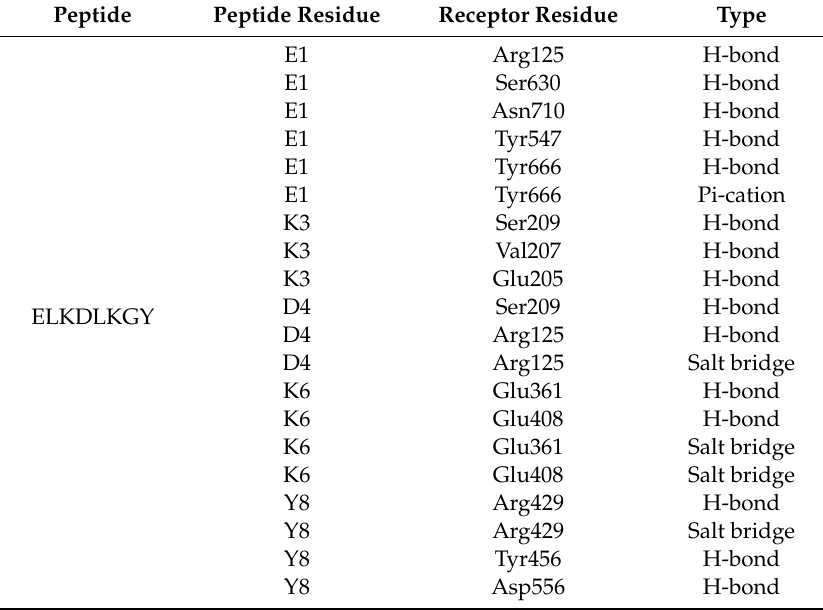
Table 3. Strong intermolecular contacts between the receptor (DPP-IV) and peptide.